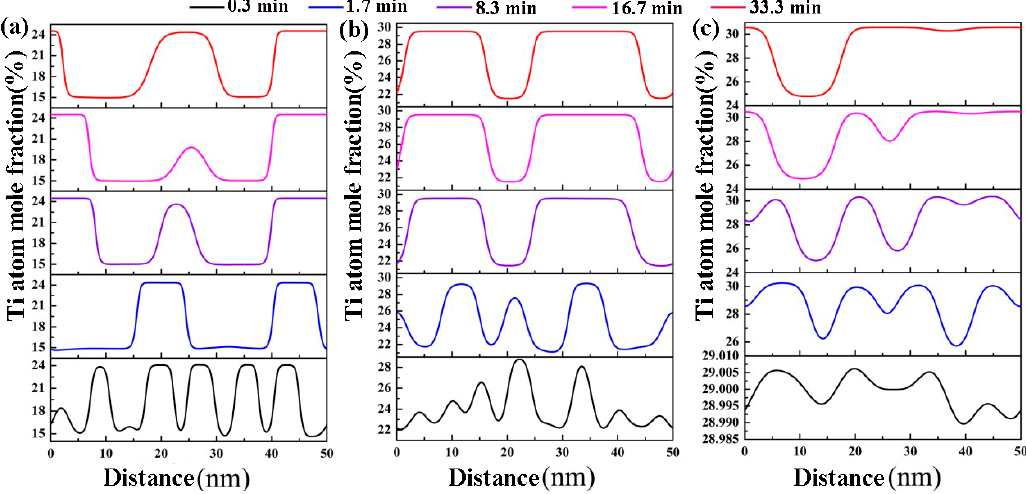
Figure 2. The Ti concentration fluctuation curve along the horizontal direction of the Zr-Nb-Ti alloys aged at 900 K for different times: ( a ) Zr-33Nb-29Ti, ( b ) Zr-40Nb-25Ti and ( c ) Zr-40Nb-20Ti. The first stage: the Ti concentration fluctuates in a small length range, corresponding to the stage of the rapid formation of the Ti-rich spinodal phases.